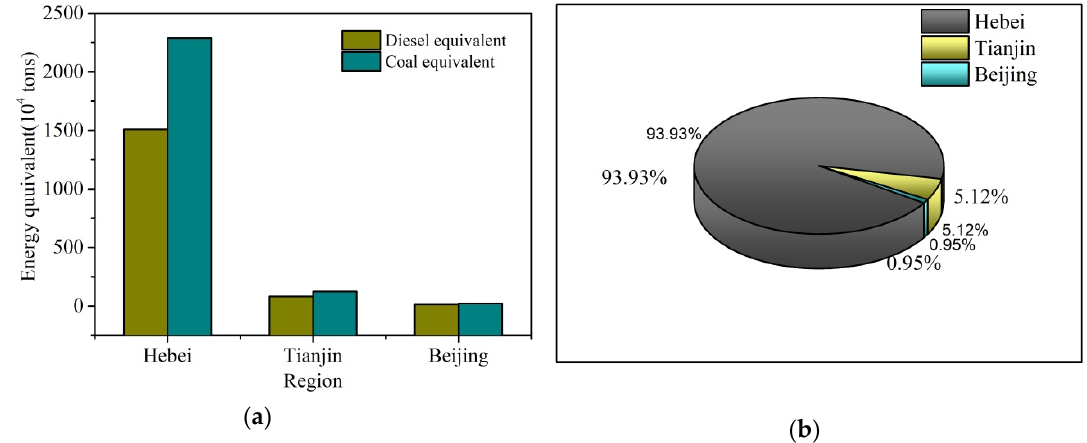
Figure 4. The energy value in the B-T-H region in 2017. ( a ) The curve of diesel equivalent and coal equivalent in Hebei, Tianjin, and Beijing, respectively. ( b ) The energy value proportion of Hebei, Tianjin, and Beijing, respectively.